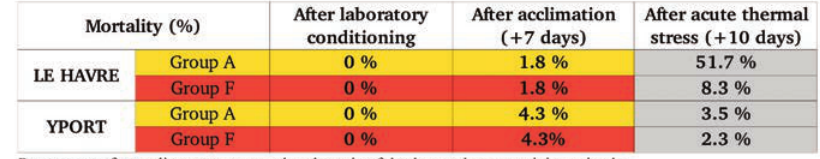
Figure 2. Mortality progression among sites and groups.